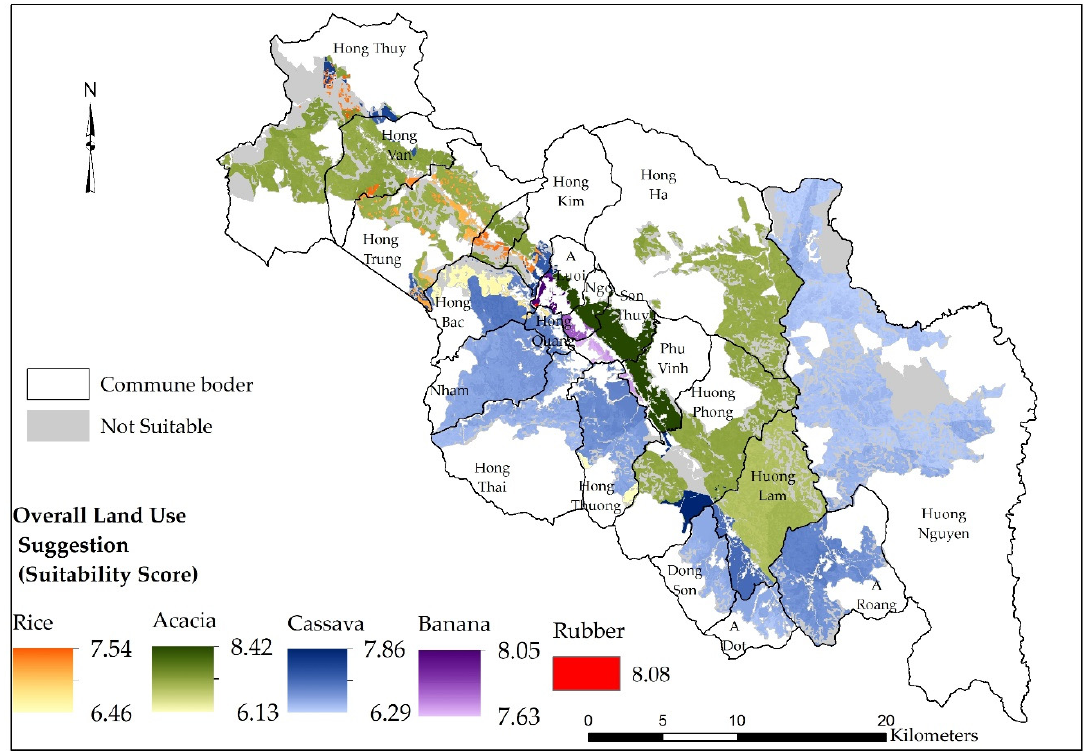
Figure 8. Overall land suitability of selected land use types for entire district